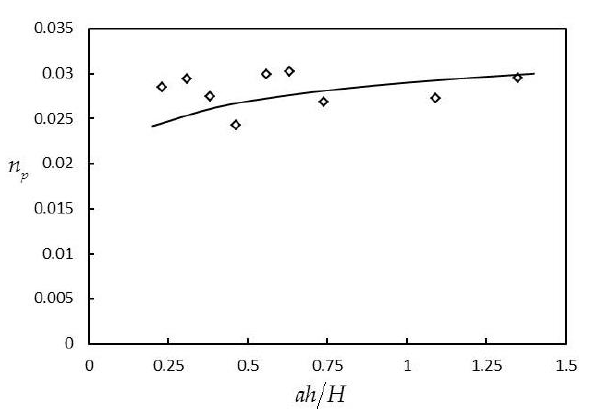
Figure 6. Influence d epth Δ s + Δ h varies with the comprehensive parameter ah/H .